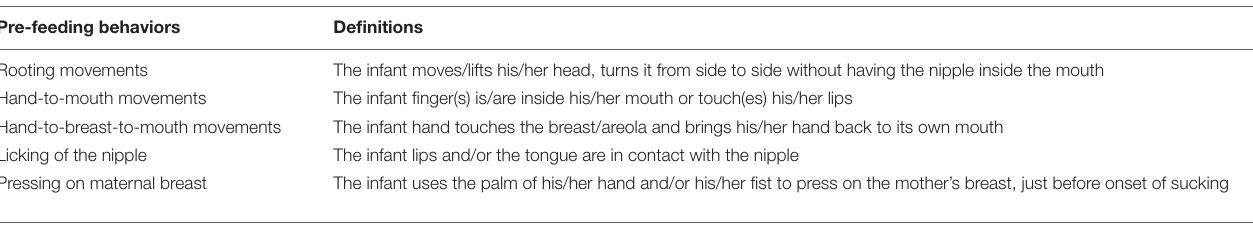
TABLE 1 | Pre-feeding behaviors and their definitions.